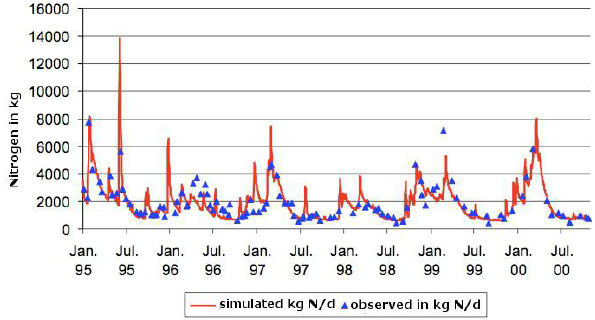
Fig. 2. Simulated and observed nitrogen concentrations in kgd − 1 of the river Gera at the gauging station